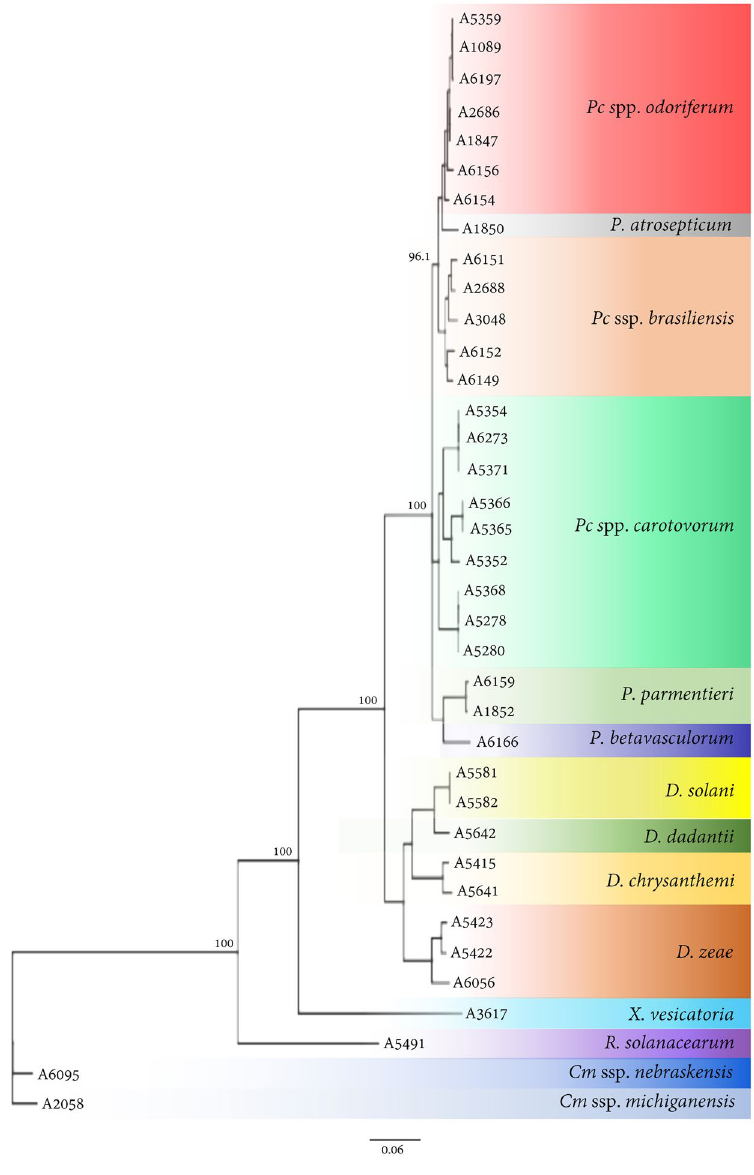
Figure 3. Phylogenetic analysis. Phylogenetic analysis of strains included in validation of recombinase polymerase amplification (RPA) for specific detection of Pectobacterium species. Consensus sequences of dnaA gene were aligned and used to calculate the phylogenetic relationships among the strains using NJ tree building method. Consensus tree was generated using Bootstrap resampling method with 1000 replicates. Details of the strains are given in Table